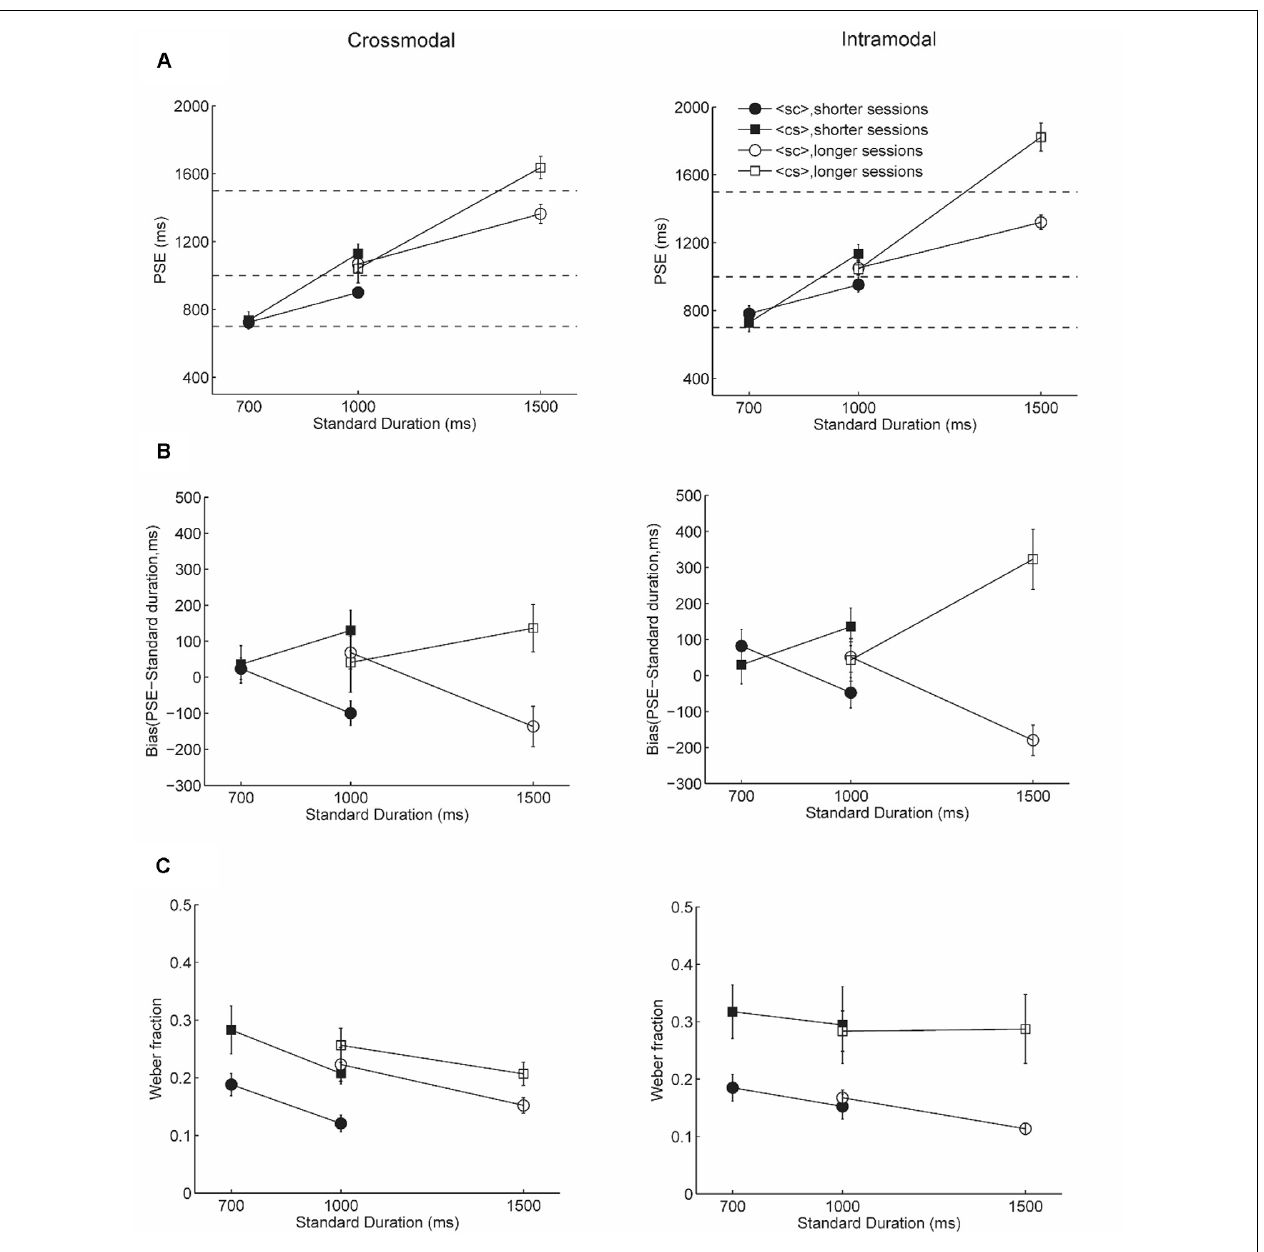
FIGURE 2 | Results of Experiment 1. Panels (A,B,C) show the point of subjective equality (PSE), bias, and Weber fraction, respectively. Left panels show results for crossmodal condition and right panels show results for intramodal condition. Solid symbols show results for the shorter sessions and empty symbols show results for the longer sessions. Circles show results for <sc> trials and squares show results for <cs> trials. The dashed lines in (A) show the veridical standard